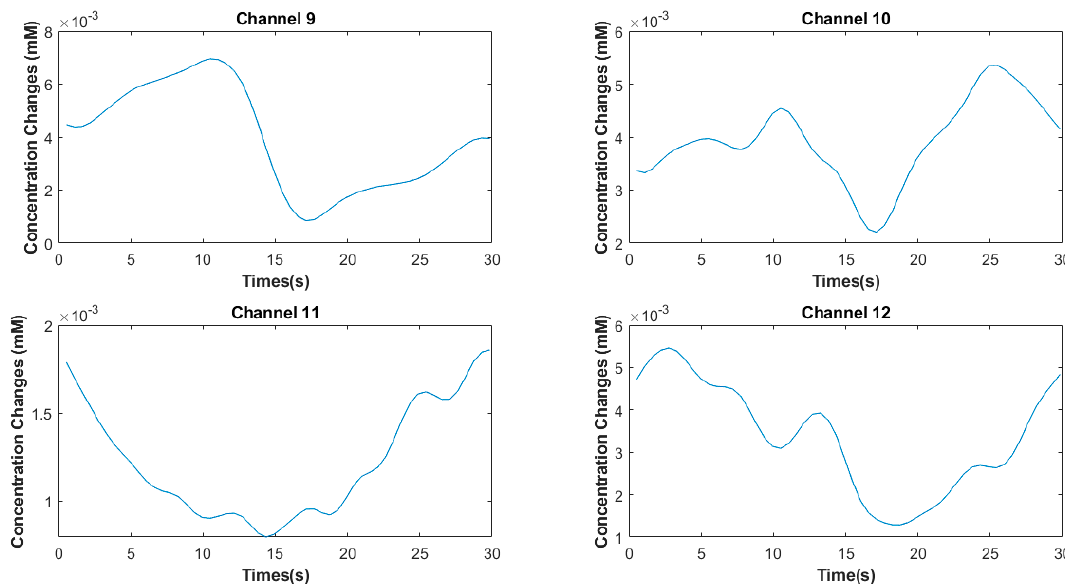
Figure 5. Average trial Δ C HbO signals of subject four for channels 9–12.